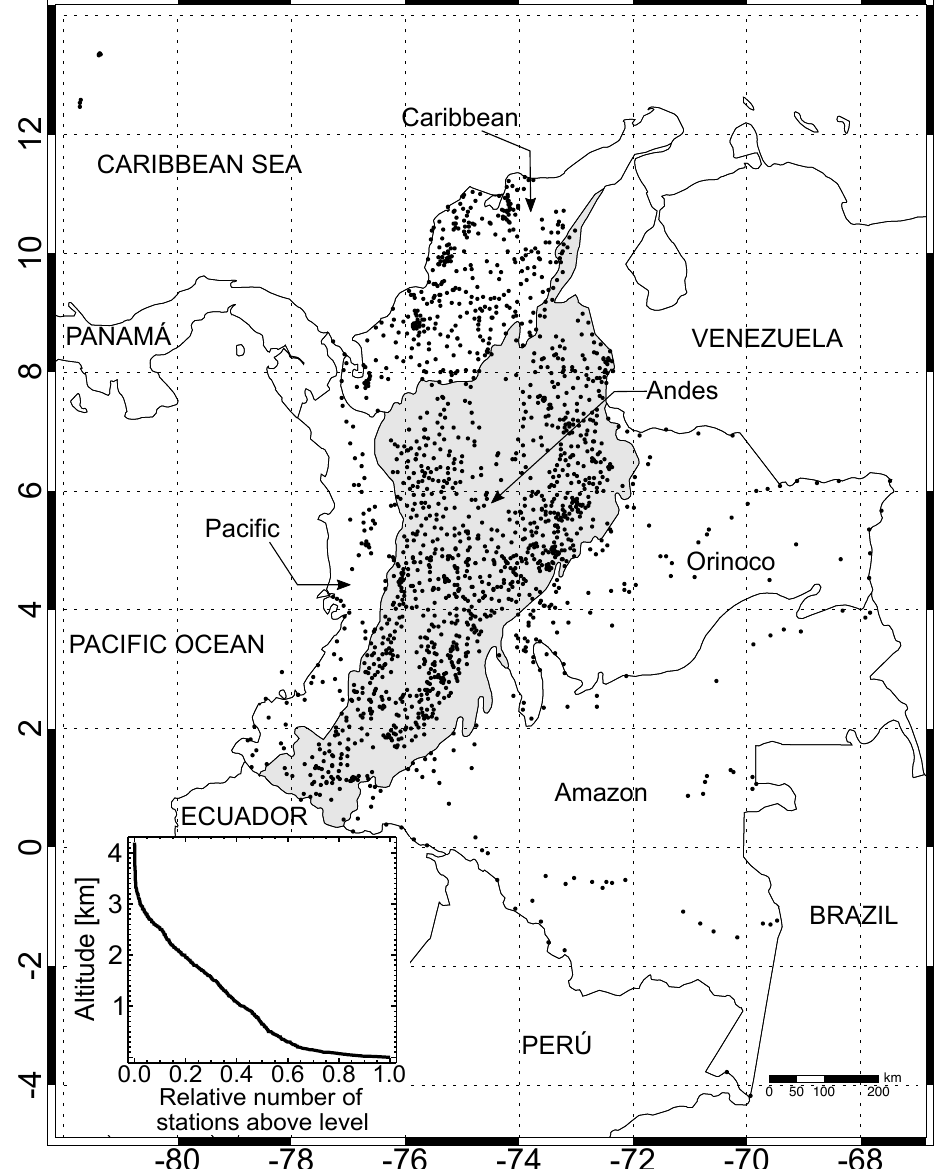
Figure 1. The points mark the location of the IDEAM rain gauge network used in this work. The bottom left graph shows the vertical distribution of the rain stations. The map also shows the five natural regions of Colombia